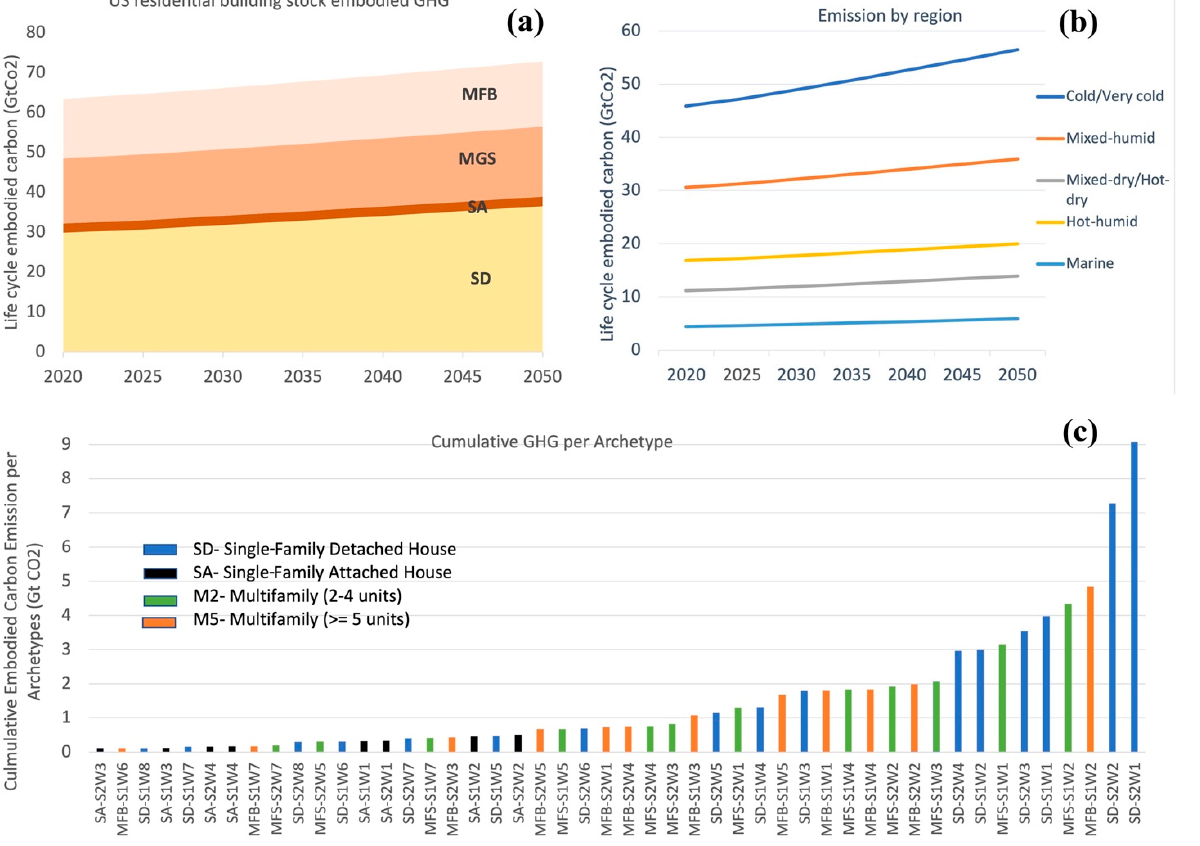
Figure 6. Embodied carbon emissions from the US residential building stock in the baseline scenario: ( a ) per housing segment, ( b ) per climate region, and ( c ) by archetype.